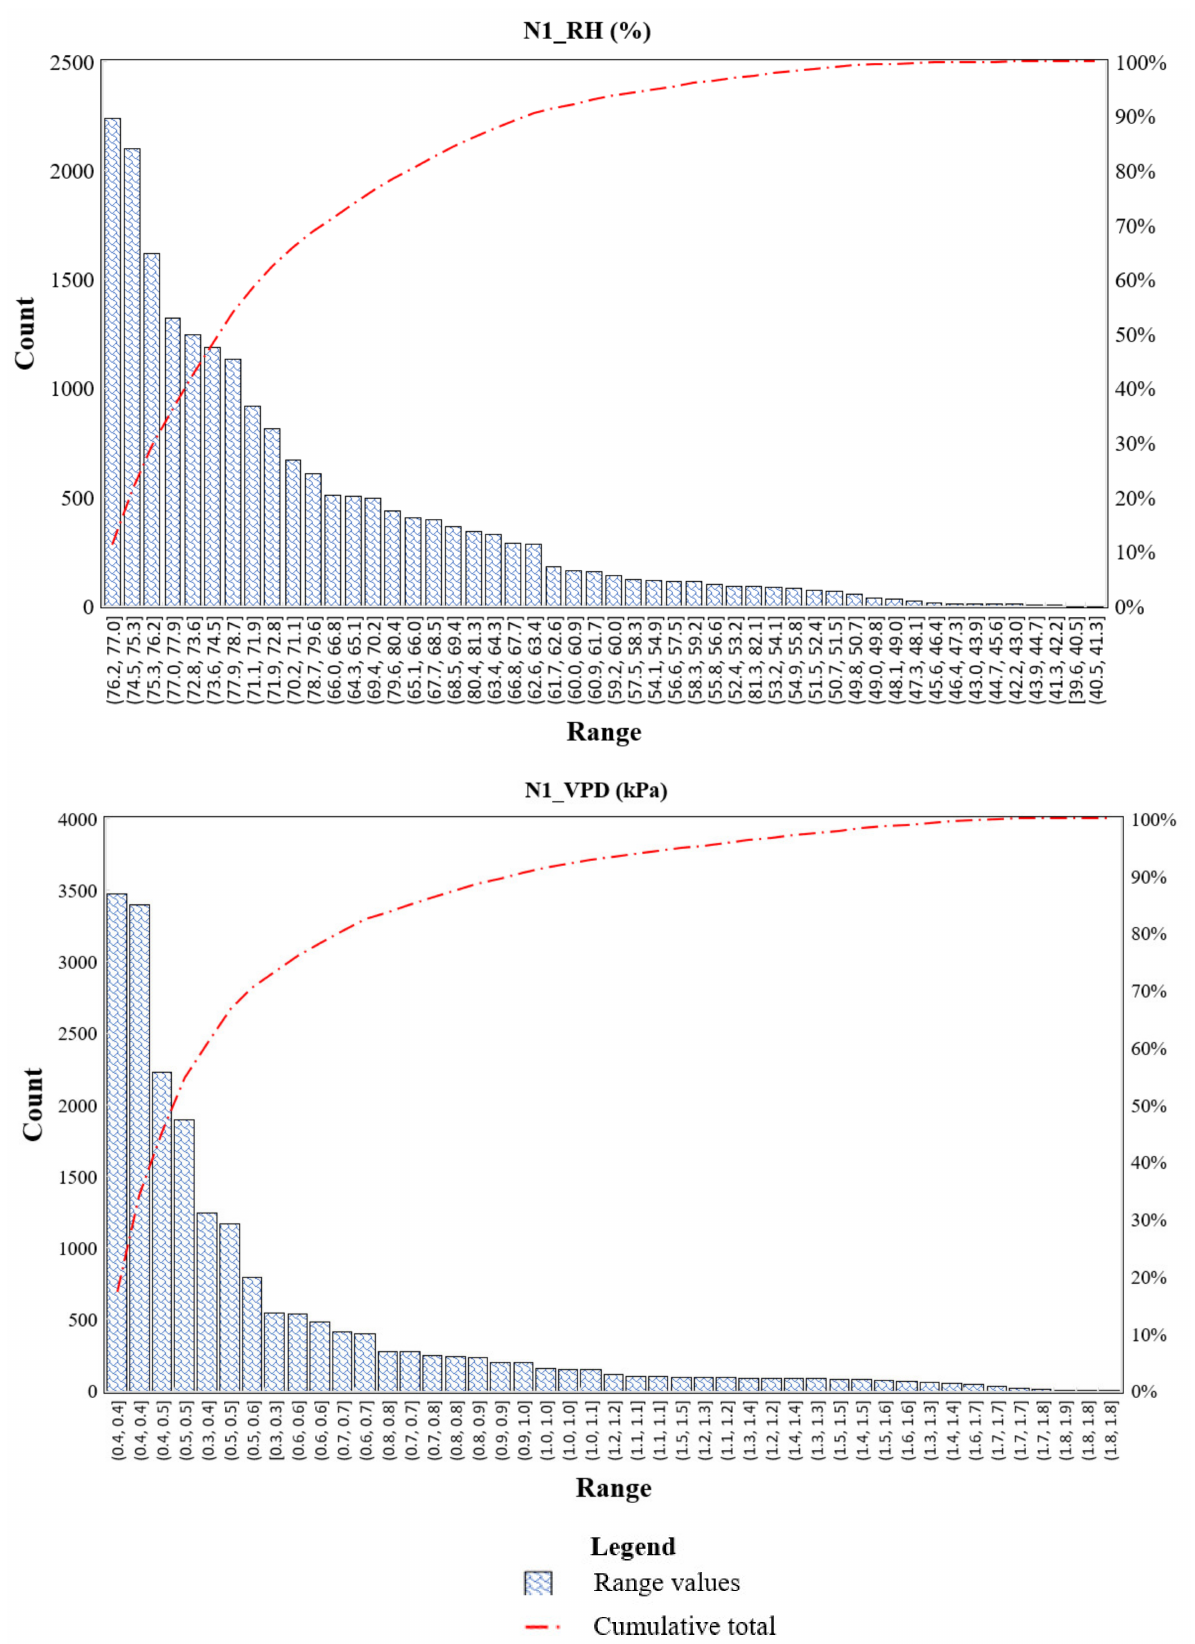
Figure 10. Pareto chart showing RH and VPD data spread at